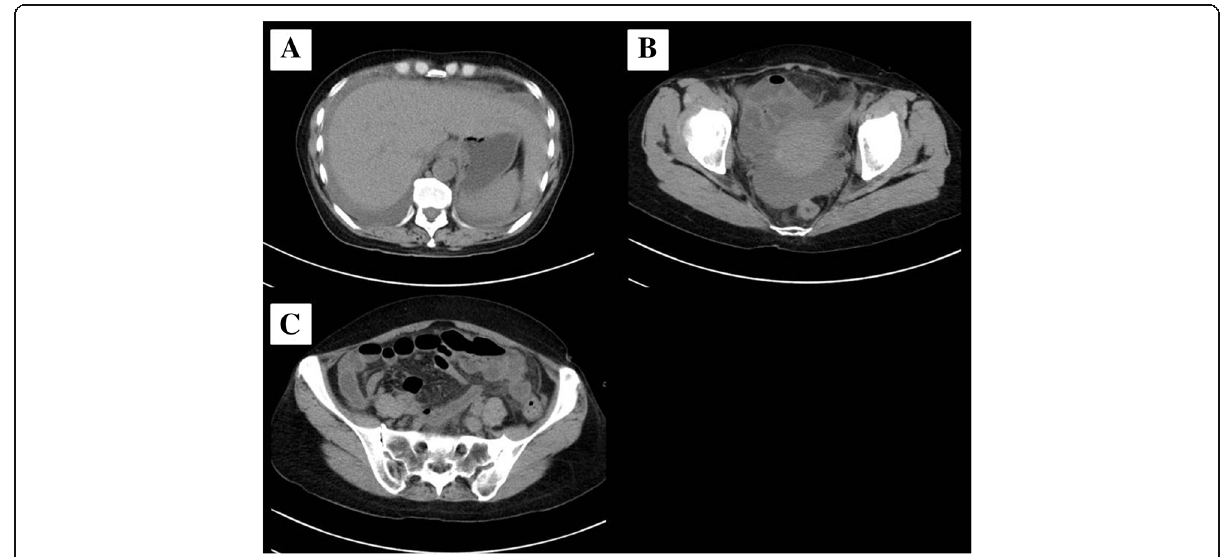
Fig. 2 Computed tomography of the abdomen. Computed tomography of the abdomen detected ascites on the liver ( a ) and Douglas ’ s fossa ( b ). CT imaging also showed intestinal edema ( c )